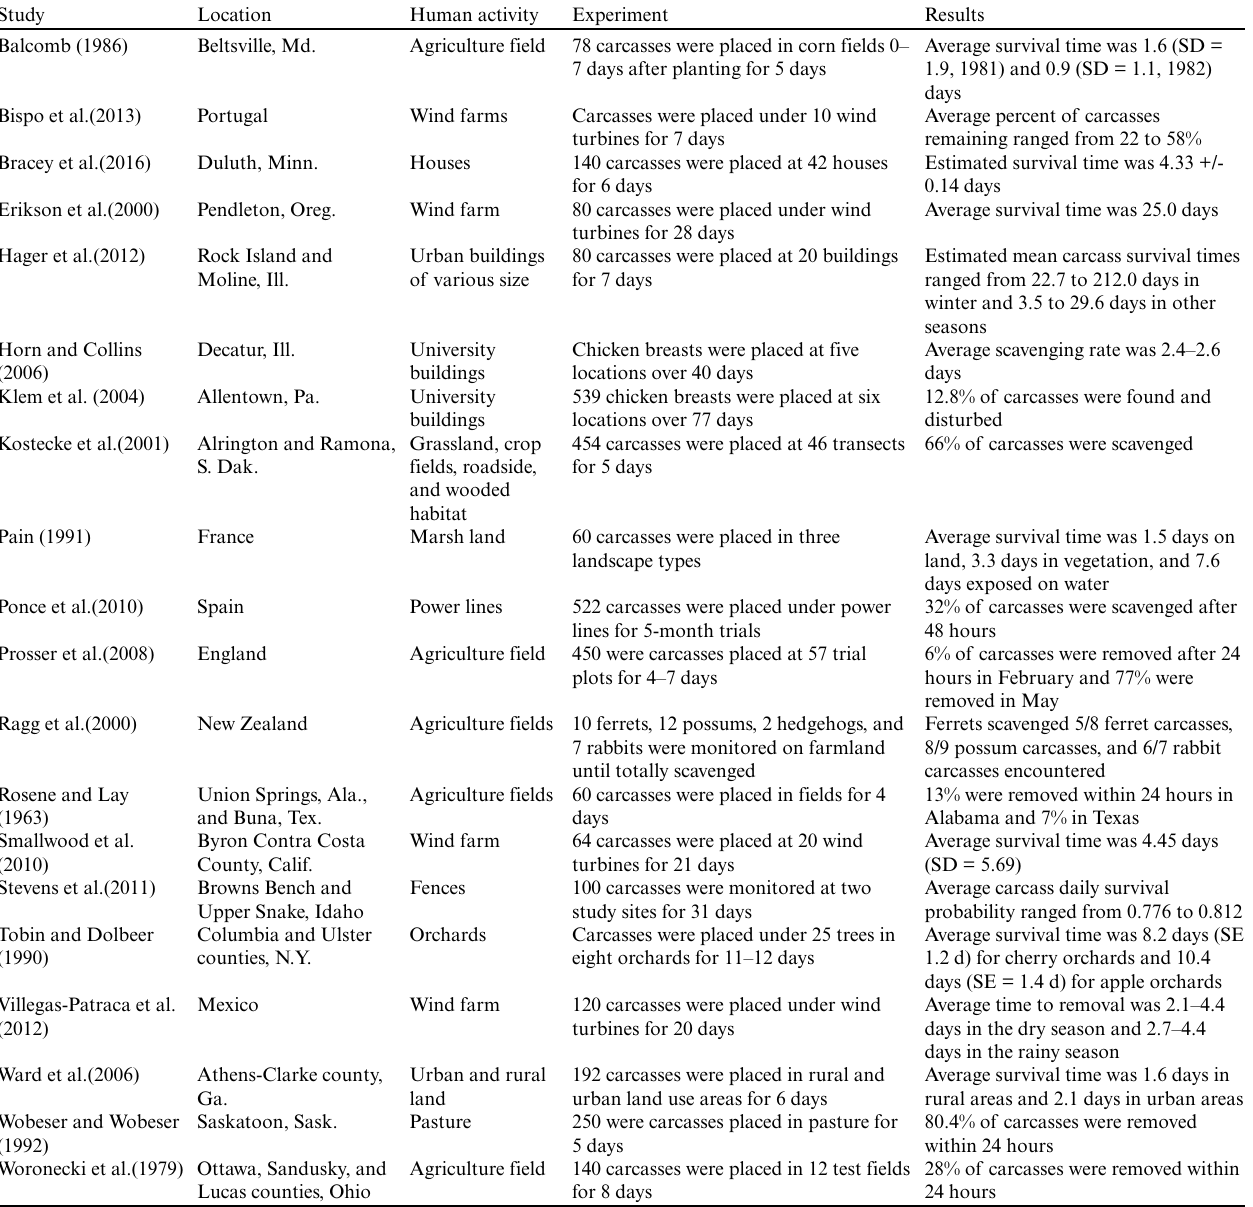
Table 1 . Summary of studies that focused on the removal of carcasses by